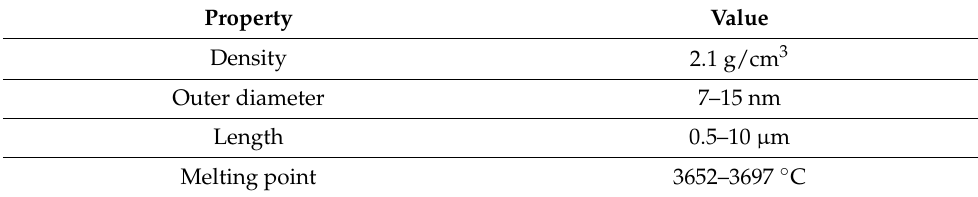
Table 3. Basic properties of